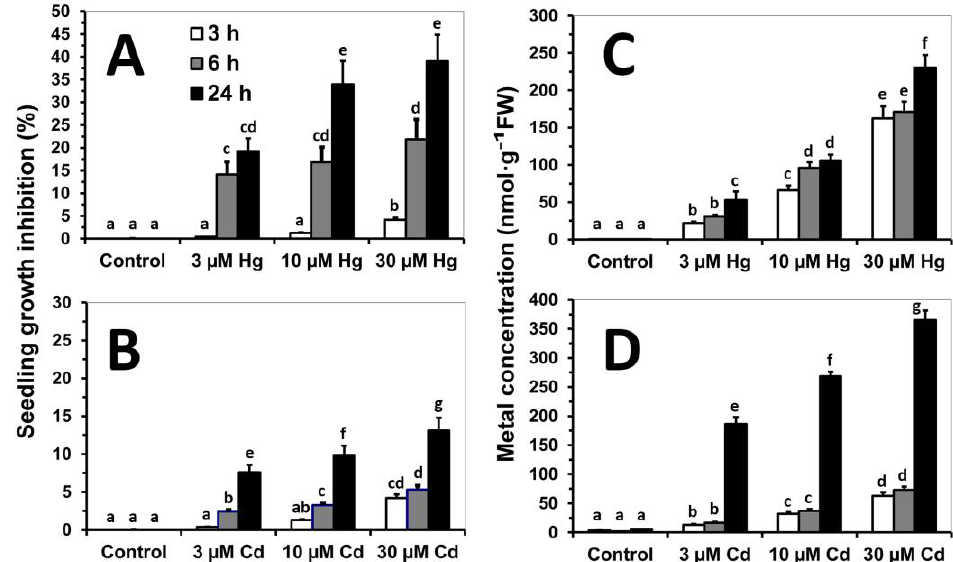
Figure 1. Relative growth inhibition (%) ( A , B ) and metal concentration (nmol g − 1 FW) ( C , D ) of Medicago sativa seedlings treated with Hg (HgCl 2 ) or Cd (CdCl 2 ) (0, 3, 10, and 30 µ M) for 3, 6, and 24 h in the microscale hydroponic system. The data are the average of four independent experiments, and the standard error (SE) bars are shown. Significant differences between treatments are shown with different letters ( p < 0.05, Tukey’s test).